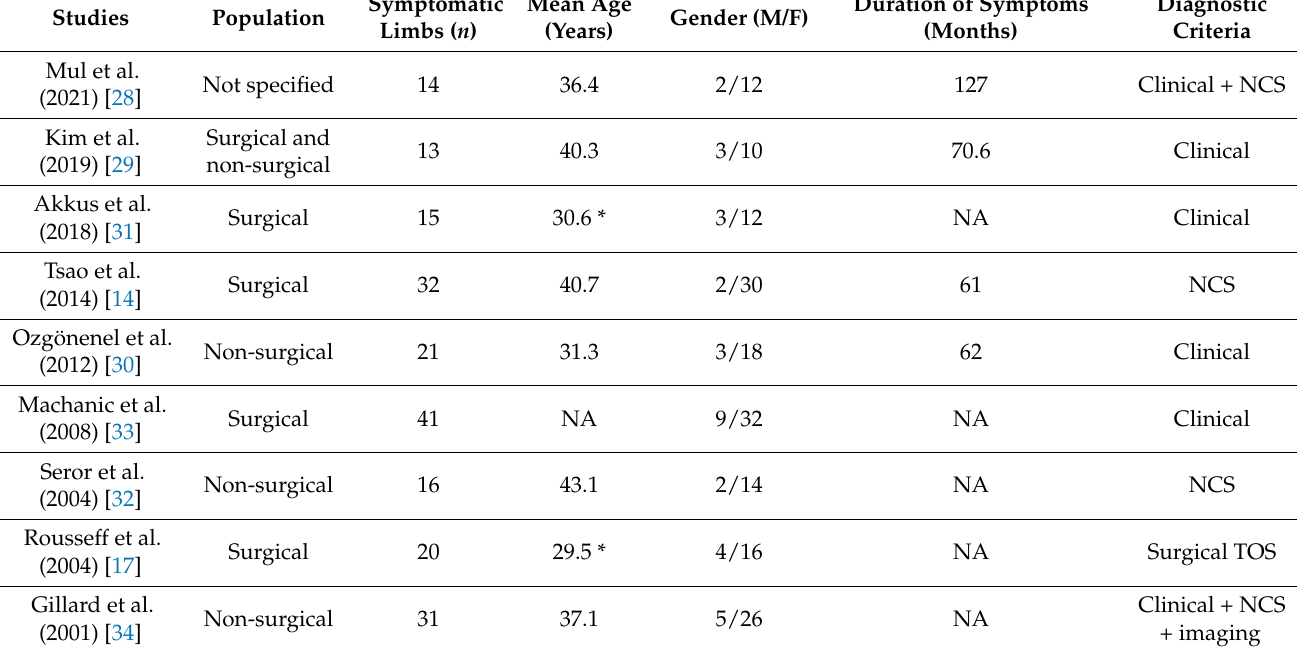
Table 1. Demographic data of the included